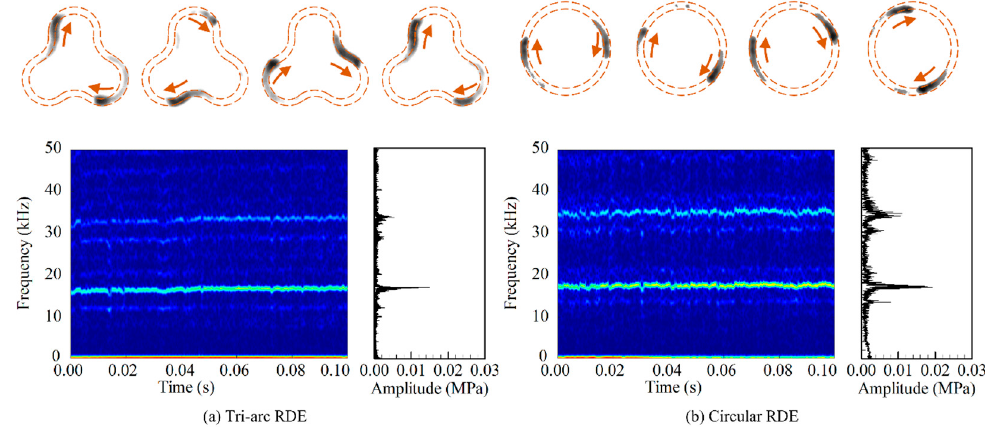
Figure 8. Experimental visualization ( upper ), STFT ( lower-left ) and FFT ( lower-right ) results at reference mass flow rate, 𝑚(cid:4662) = 80.3 ± 0.20 g/s for Φ = 1.04 ± 0.001 ; tri-arc ( a ) and circular ( b ) RDEs.